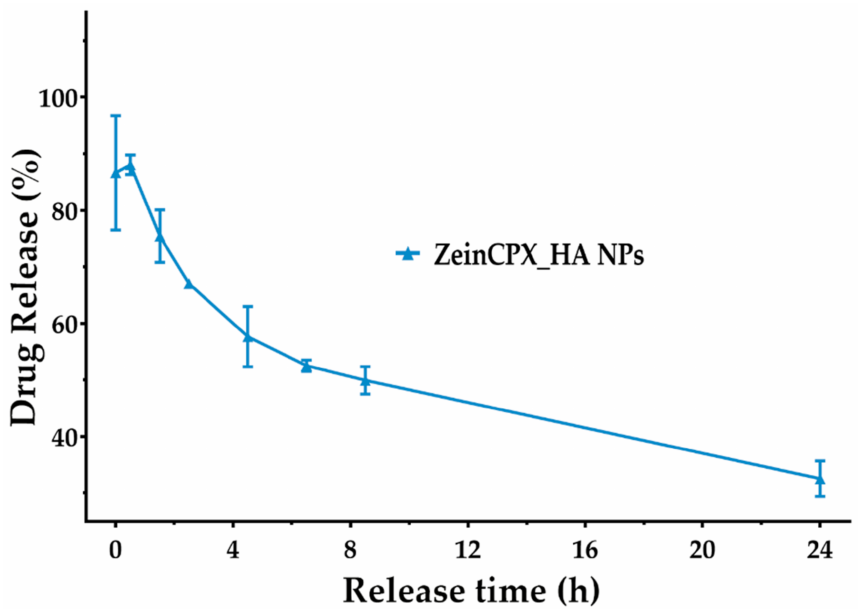
Figure 6. Release profile of ZeinCPX_HA NPs in STF at 37 ◦ C, pH = 7.4 for 24 h (non-cumulative). Results are presented as mean ± SEM ( n =